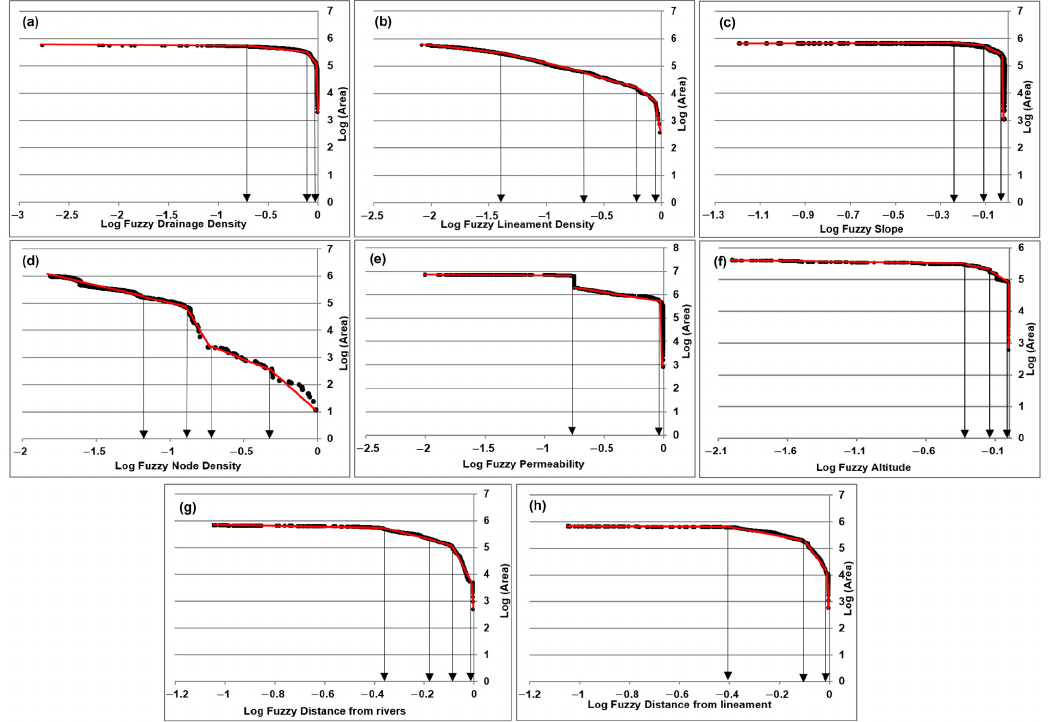
Figure 5. Concentration-area (C-A) log-log plots for the transformed values: ( a ) drainage density map; ( b ) lineament density map; ( c ) slope map; ( d ) node density map; ( e ) permeability map; ( f ) altitude map; ( g ) distance from rivers map; ( h ) distance from lineament map.